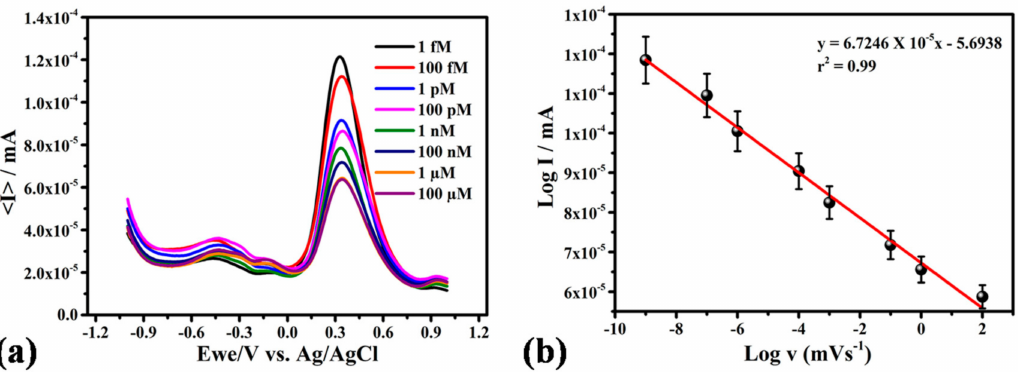
Figure 5. ( a ) Differential pulse voltammogram of different target DNA concentrations ( Escherichia coli Shiga toxin) ranging from 1 fM–100 µ M, at the scan rate of 100 mV/s. ( b ) Calibration plot obtained between log of the various concentrations of dsDNA and peak current.